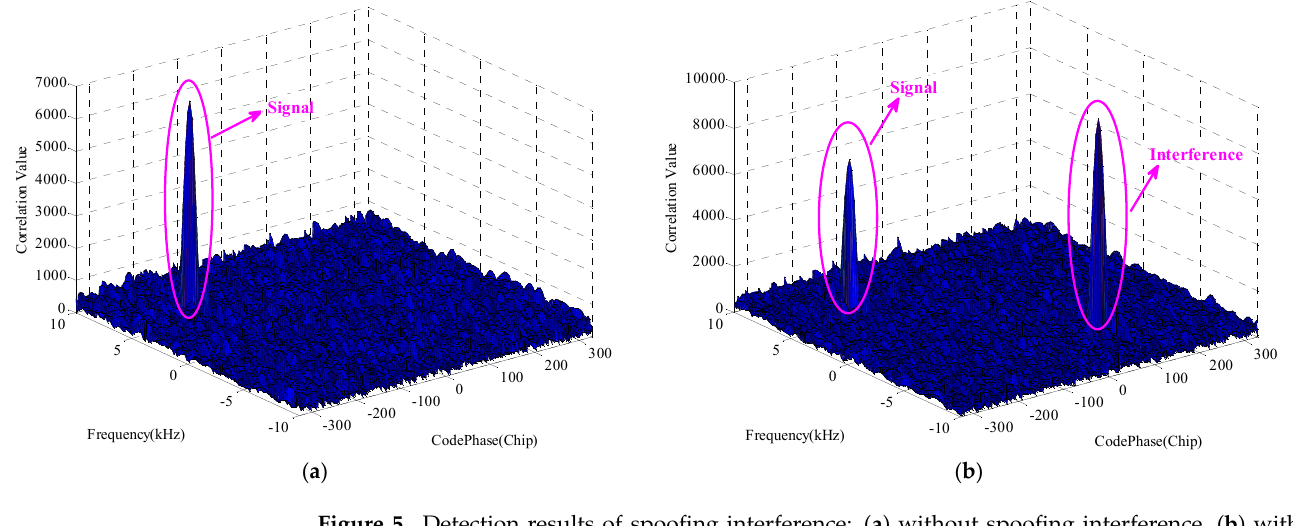
Figure 5. Detection results of spoofing interference: ( a ) without spoofing interference, ( b ) with spoofing interference.